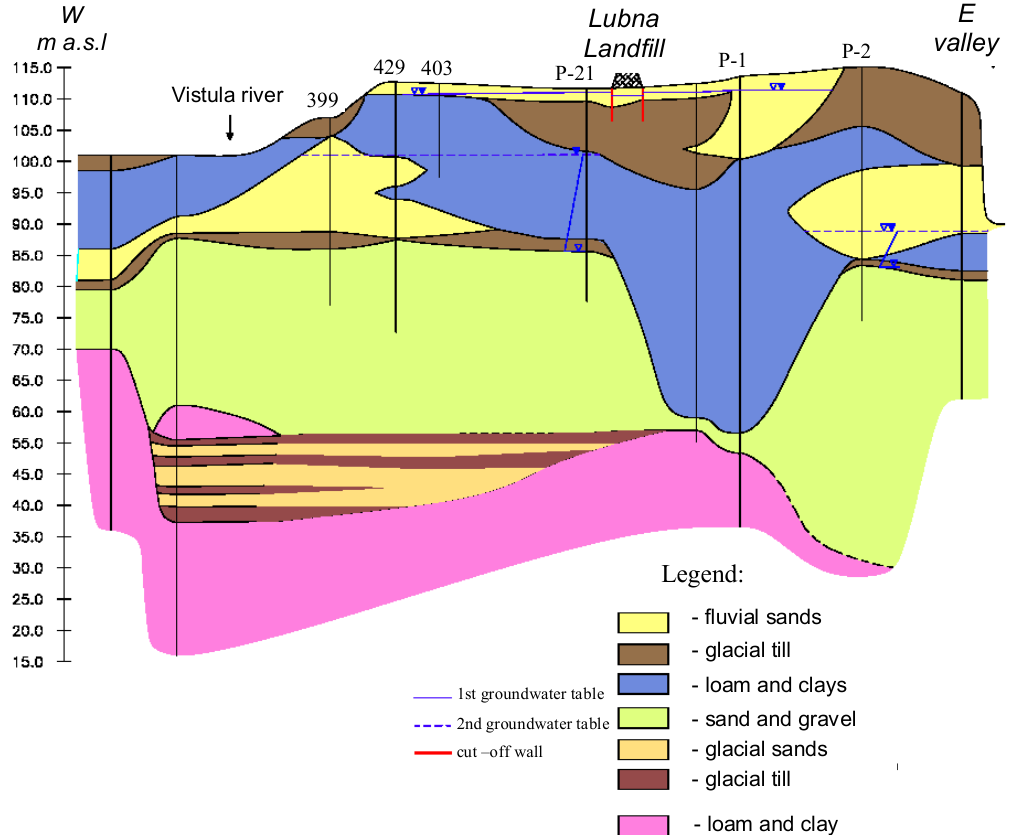
Figure 4. Geological cross-section of Lubna Landfill